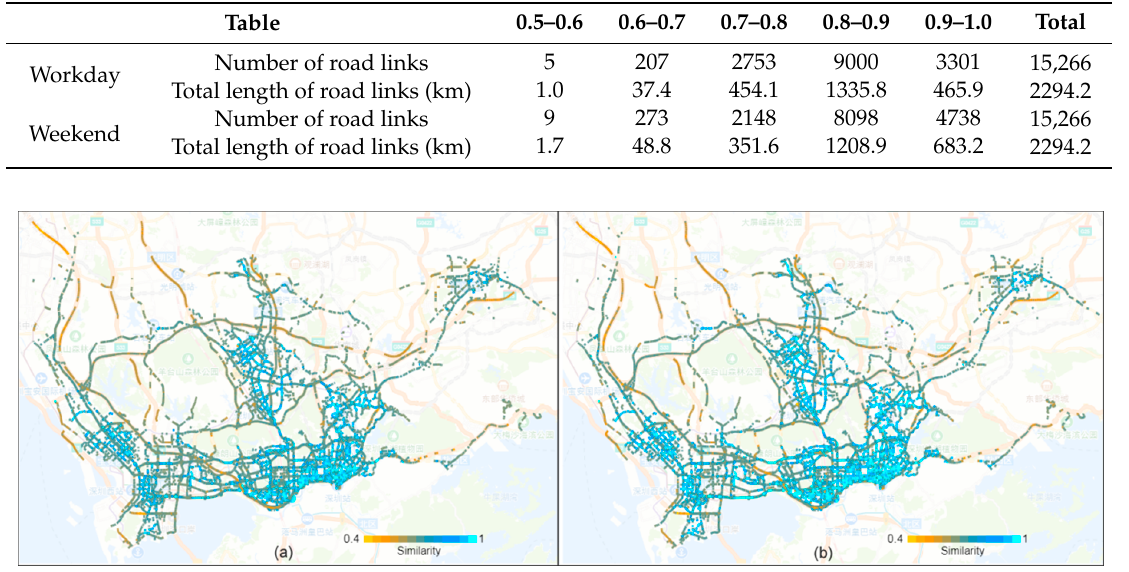
Figure 3. Similarity of the traffic patterns of each road link. ( a ) Workday. ( b ) Weekend.